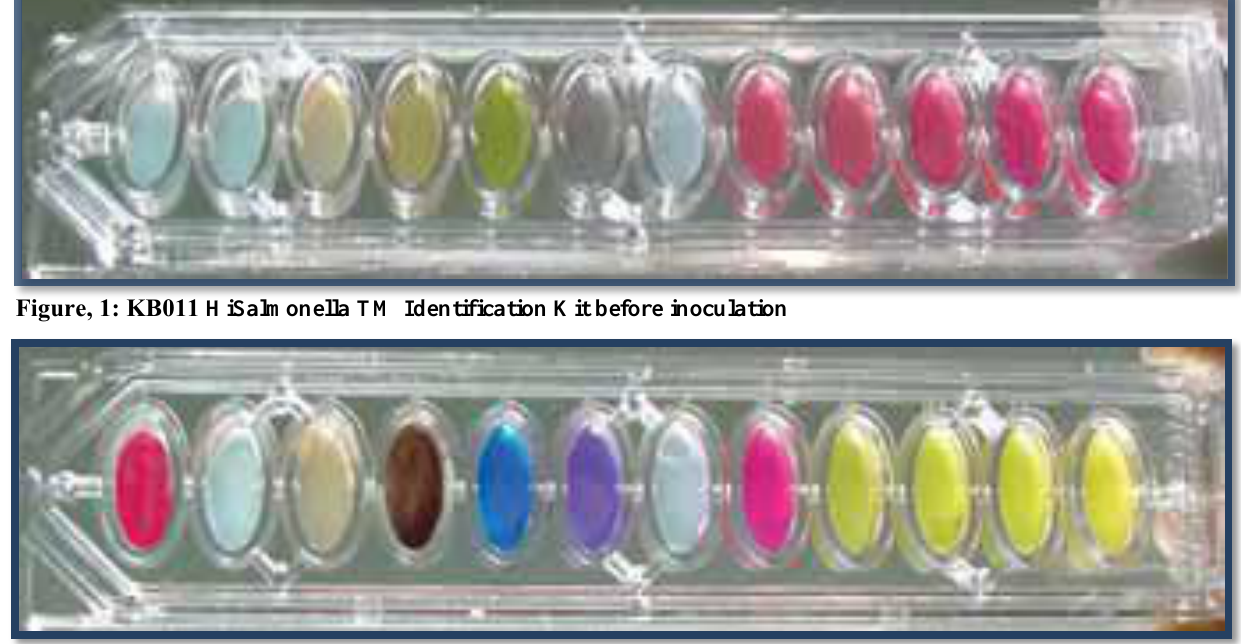
Figure, 2: KB011 HiSalmonella TM Identification Kit after